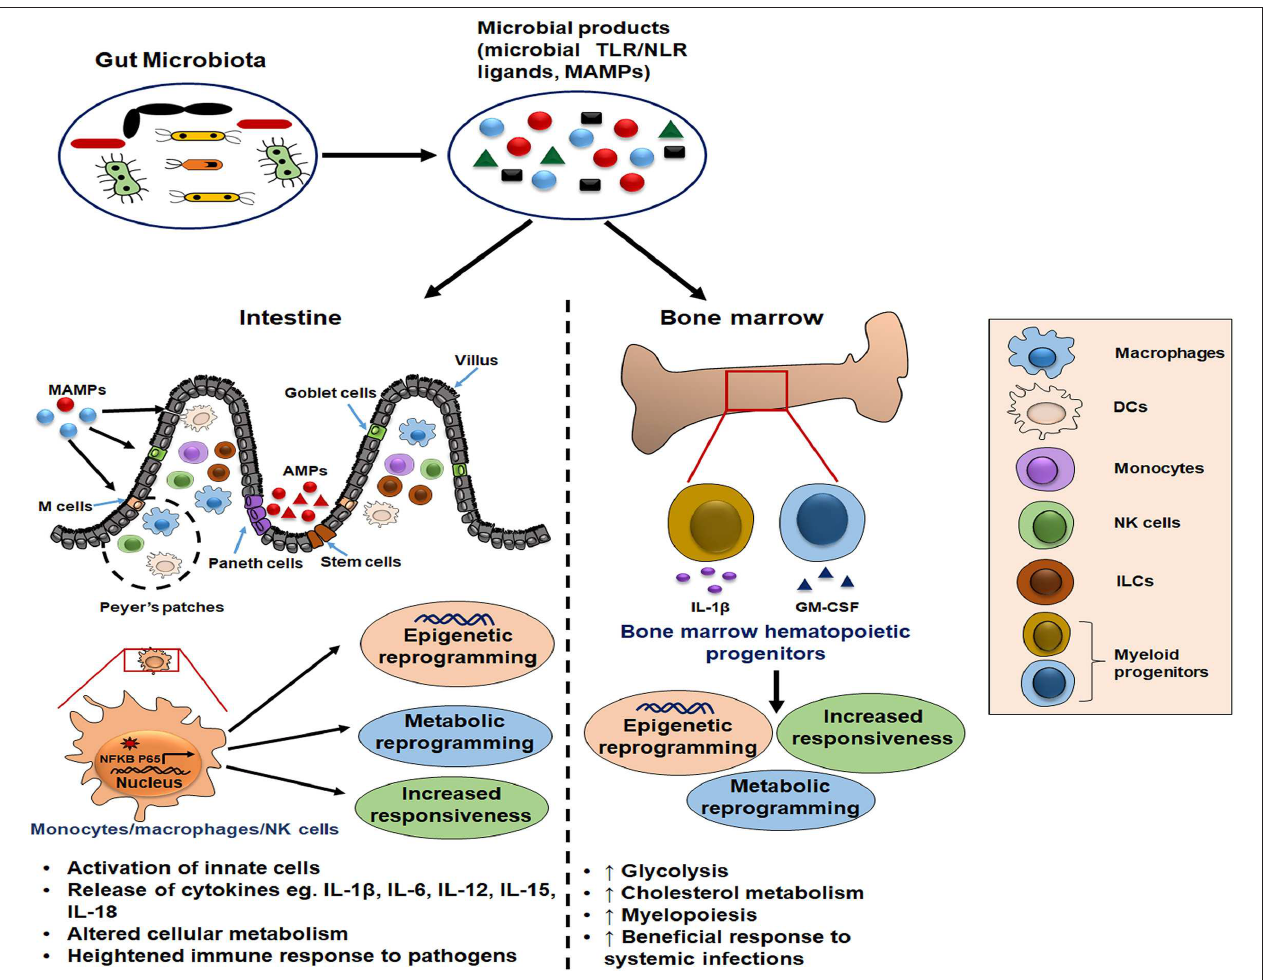
FIGURE 1 | Schematic illustration of gut microbiota as potential inducer of innate memory. The gut microbial products serve as a source of microbe-associated molecular patterns (MAMPs) that bind pattern recognition receptors (PRRs) on innate cells such as monocytes/macrophages and natural killer (NK) cells. Further, this cell activation is accompanied by the epigenetic and metabolic reprogramming which is responsible for their increased cytokine release and heightened immune response upon the subsequent pathogenic exposure. Moreover, these microbial ligands reach the bone marrow through blood circulation and condition the hematopoietic progenitors to induce long-term memory traits and enhance myelopoiesis for mounting the beneficial inflammatory response during systemic infections.